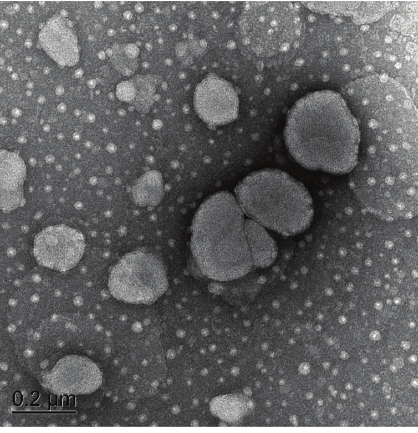
Figure 2: Transmission electron microphotography of tacrolimus ethosomes. Table 1: Physicochemical characteristics of tacrolimus-loaded liposomes and